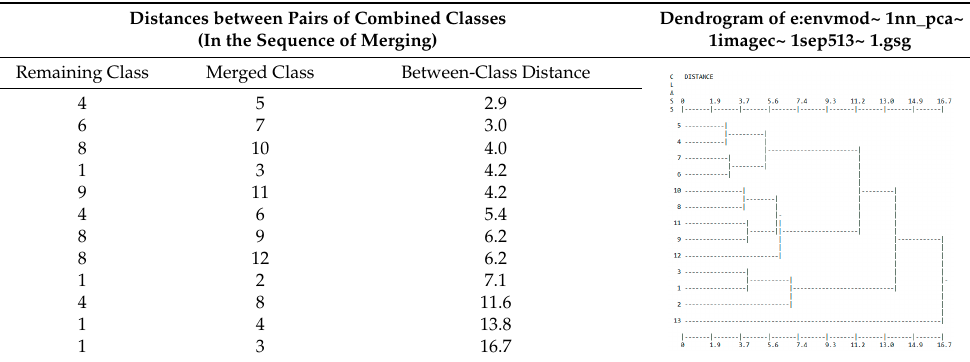
Figure 3. Automated geospatial model developed in ArcGIS ModelBuilder to obtain the landuse classification map (raster) of the study area. Table 4. WARD minimum variance result obtained with DENDROGRAM analysis of the unsupervised classification of the 5 September 2013 Landsat False Color Composite image.